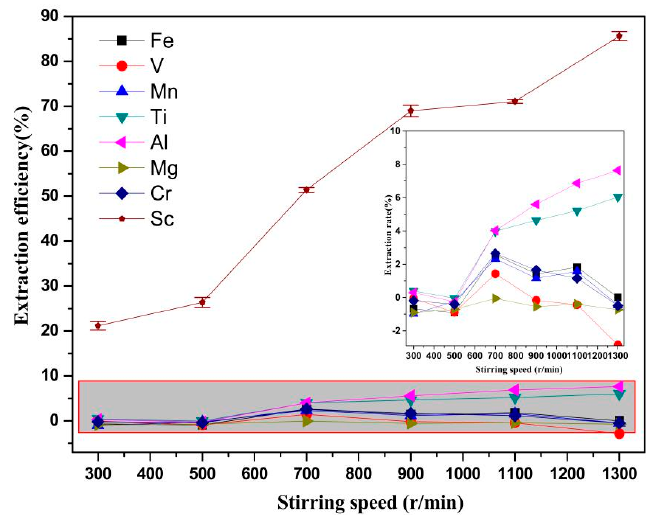
Figure 6. Effect of stirring speed on the Sc extraction (8% of D2EHPA, 2% of TBP, O/A 1:10, pH= − 0.75,